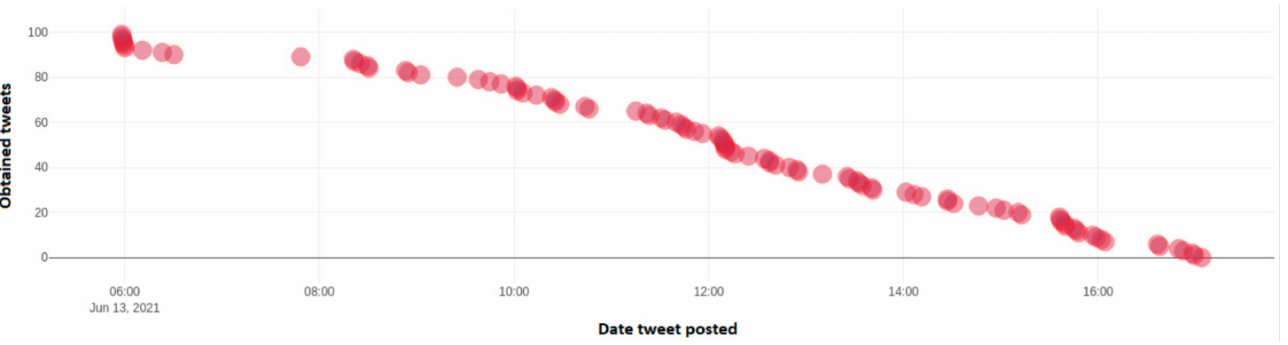
Figure 21. Mined tweets based on negative hashtag (# συριζωα ) (100 tweet sample) for SYRIZA party.